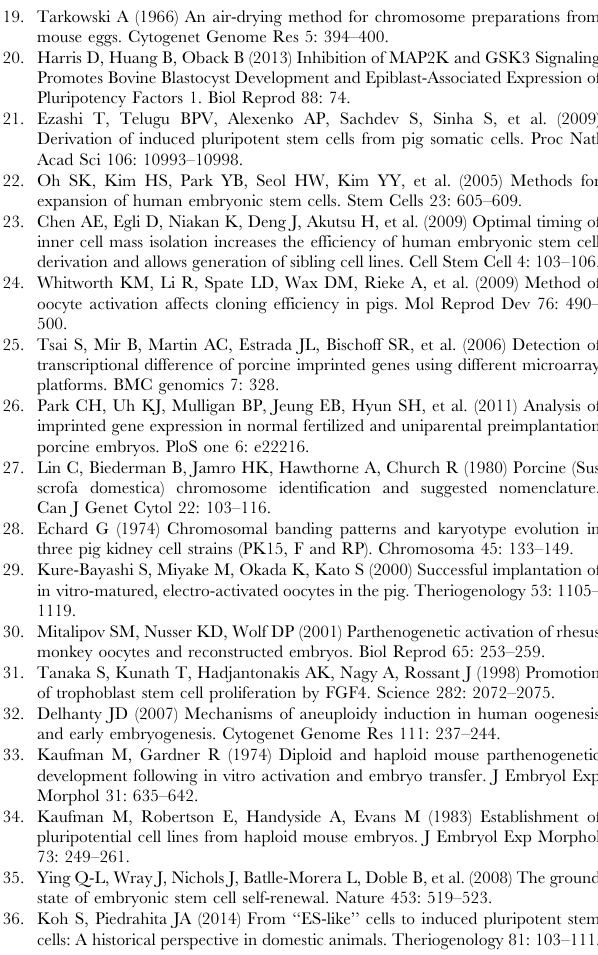
Figure S2 The chromosome spread of PA embryo- derived fibroblasts. (A–F) The chromosome spread of aneuploid blastomeres, contain 15,16,17,22,22 and 28 chromo- somes, respectively. (G–I) The chromosome spread of diploid blastomeres, respectively. Table S1 The detailed information of porcine parthe- nogenetic fetuses. Table S2 The karyotypes of porcine parthenogenetic fetal fibroblasts before